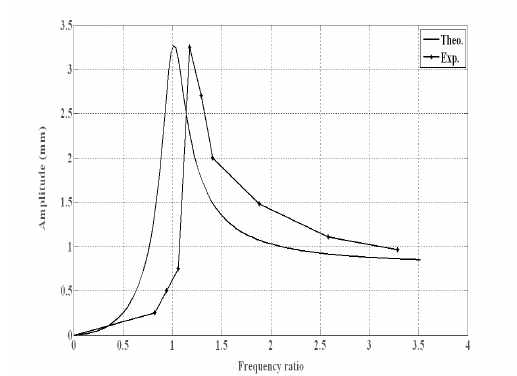
Fig.12. Shows the varaition of the amplitude versus frequency ratio for m=0.386 kg,and e=0.08